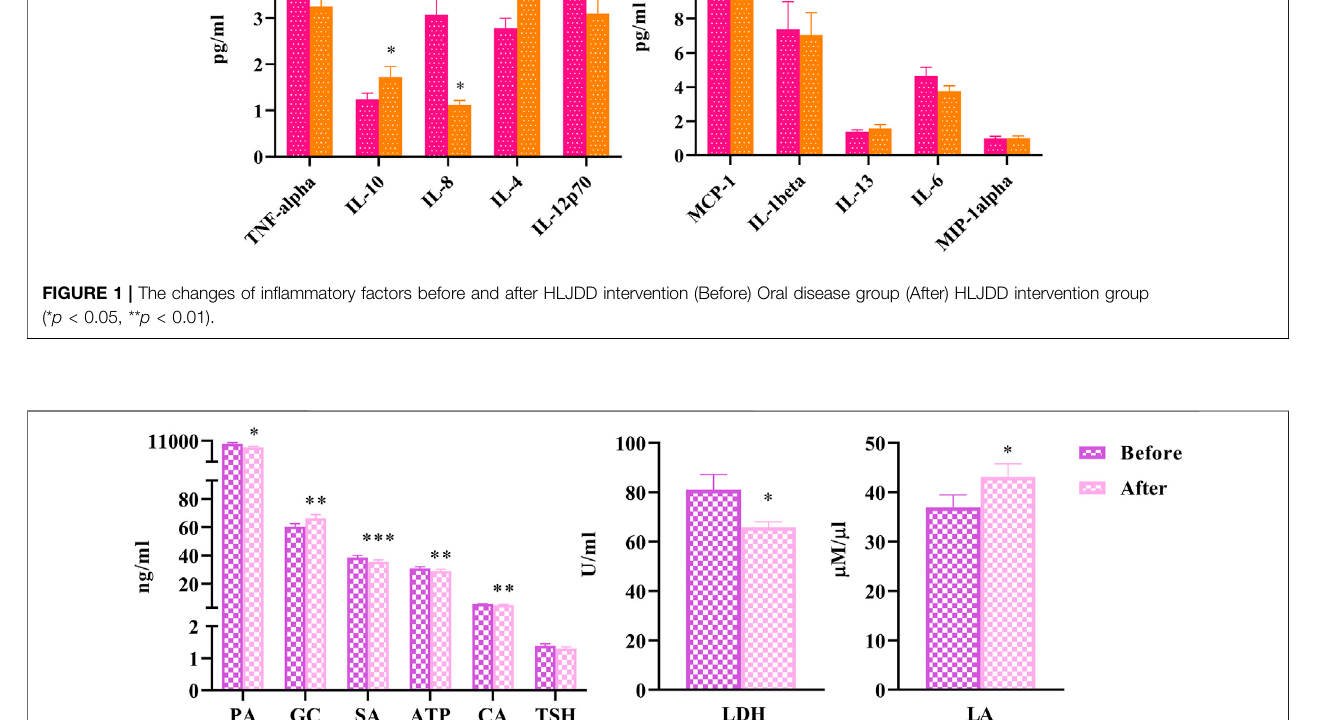
Frontiers in Pharmacology |